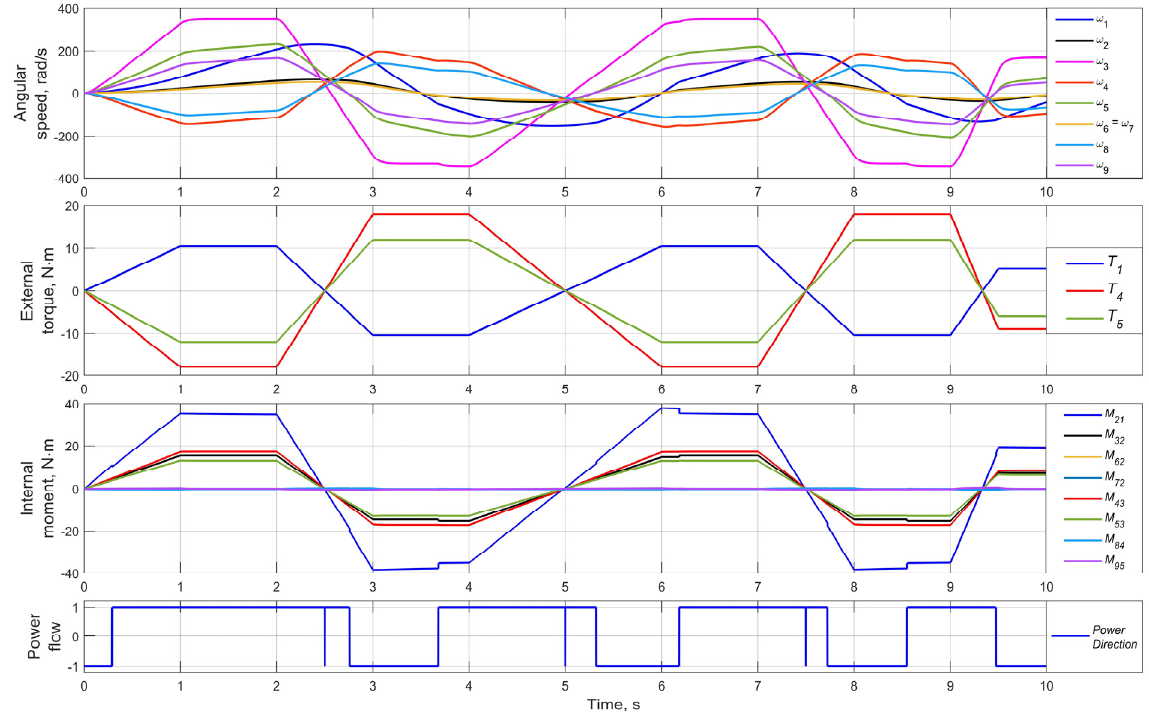
Figure 7. Modeling the mode of a conventional inter-axle differential.